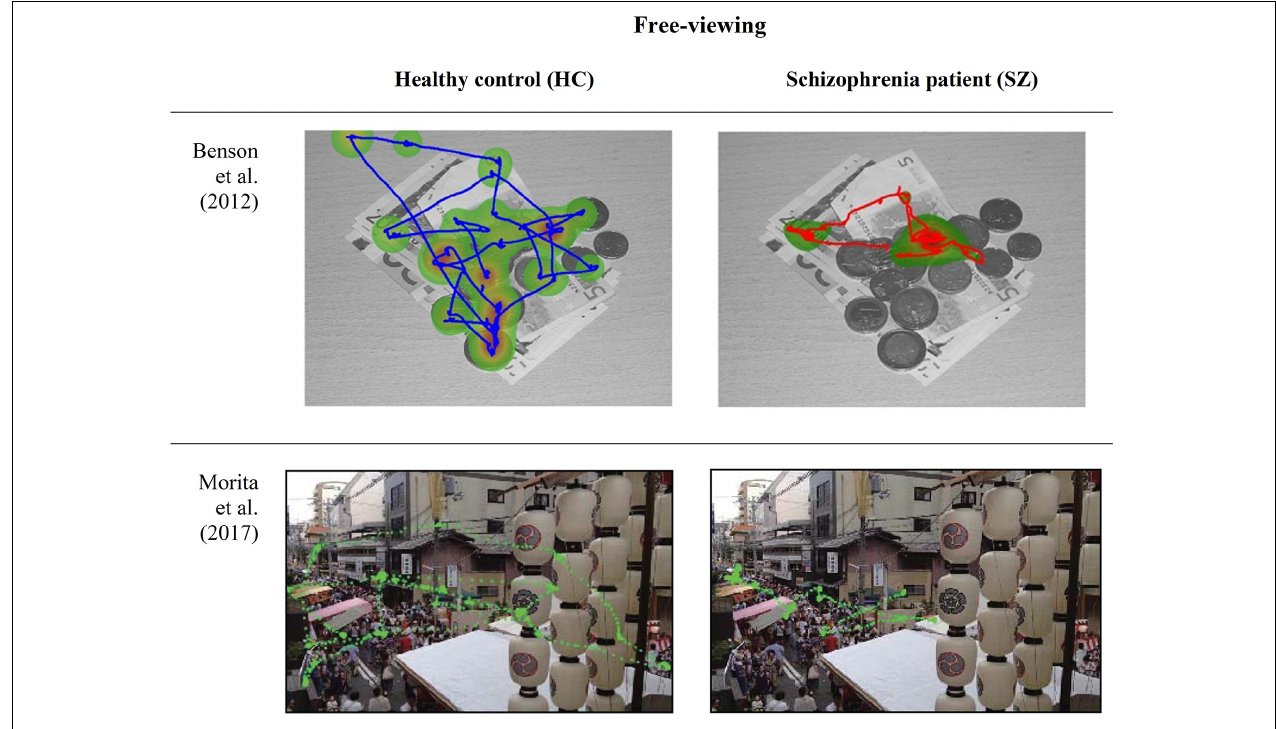
FIGURE 3 | Eye-movement recordings of a patients with schizophrenia (SZ) and healthy controls (HC) during a free-viewing paradigm, obtained from Benson et al. (2012) and Morita et al.